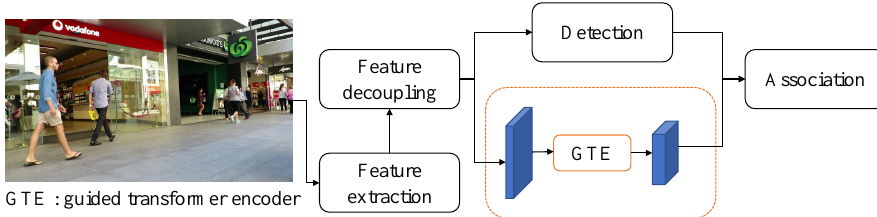
Figure 11. Computational cost minimization using the model [56] with the MOT15 benchmark